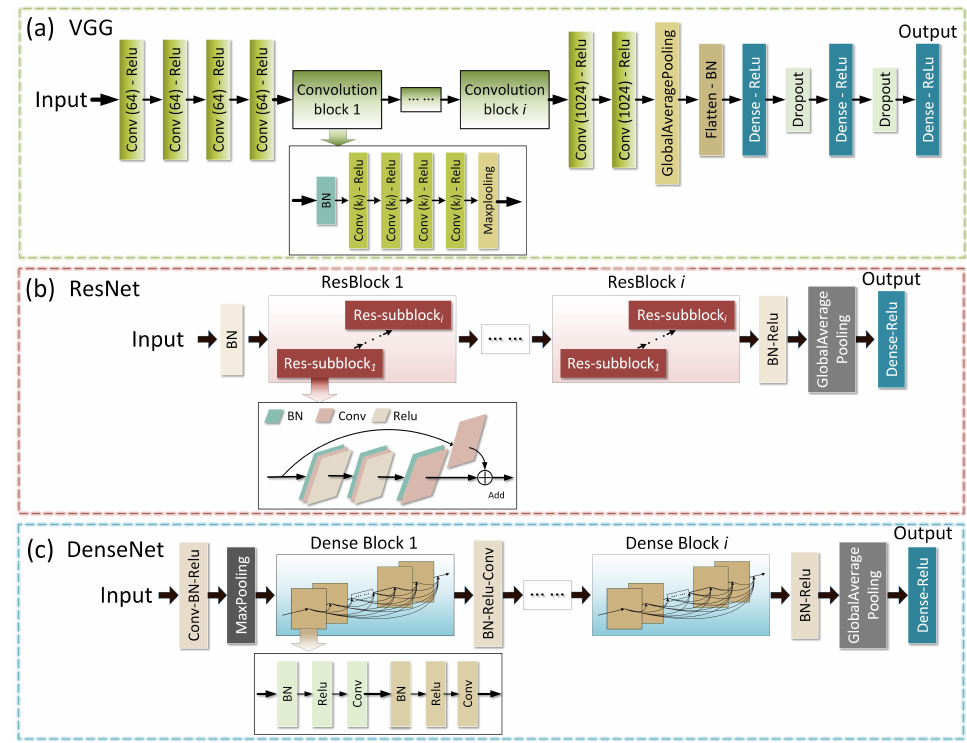
Figure 2. The structure of the DCNs (deep convolution networks). ( a ) The VGG Net (Visual Geometry Group Networks). ( b ) The ResNet (Residual Networks). ( c ) The DenseNet (Densely Connected Convolutional